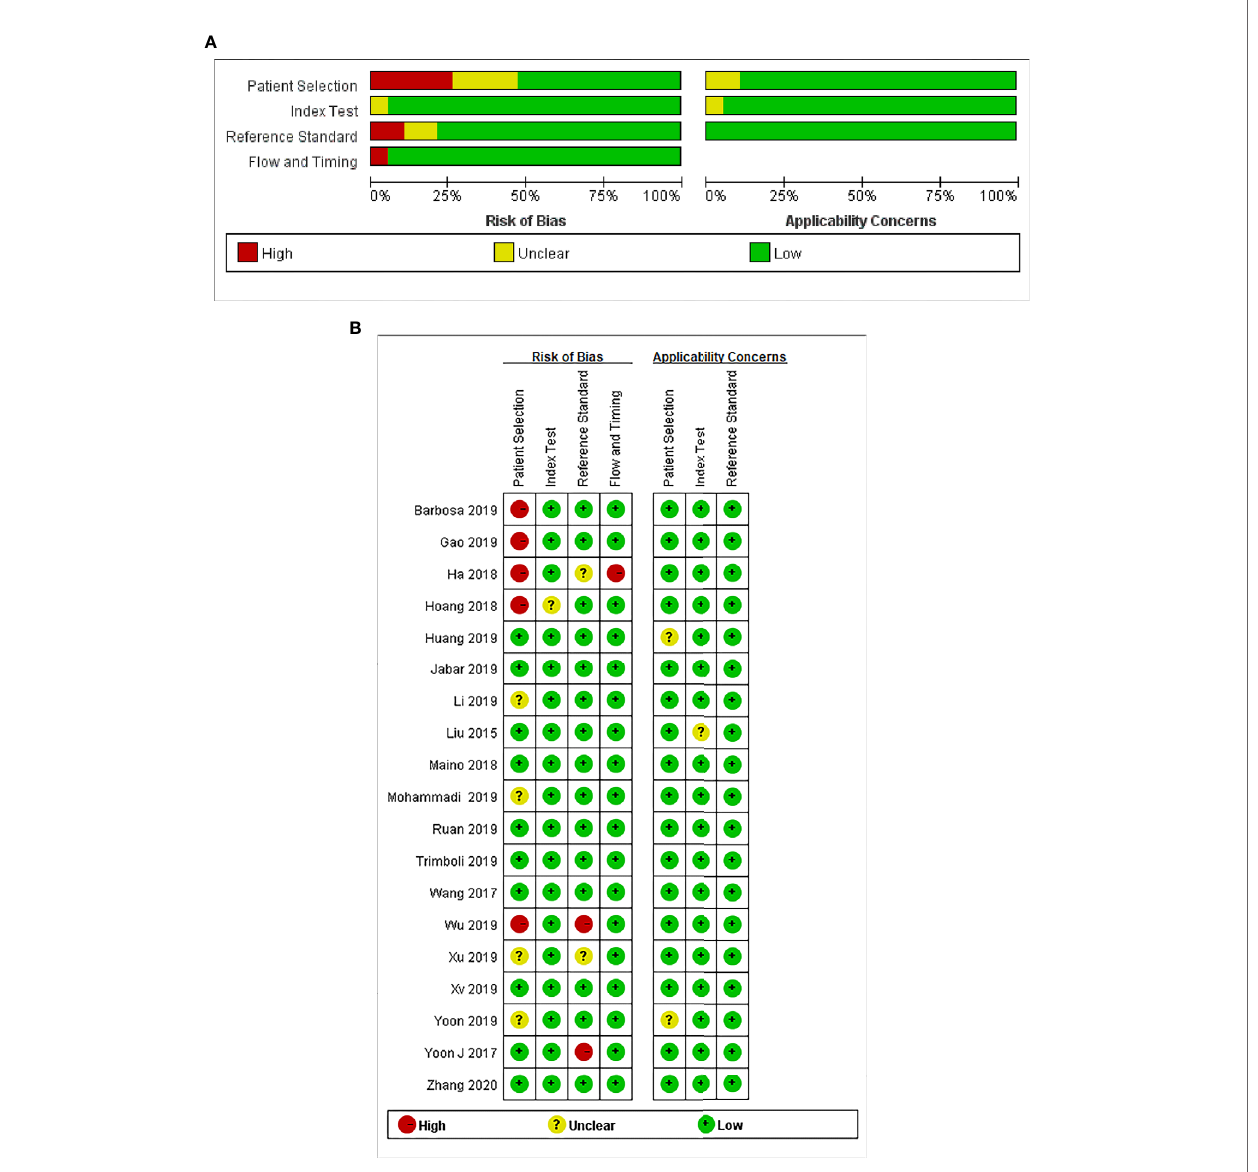
FIGURE 2 | (A) Risk of bias and applicability concerns graph: review authors ’ judgments about each domain presented as percentages across the included studies. (B) Risk of bias and applicability concerns summary: review authors ’ judgments about each domain for each included